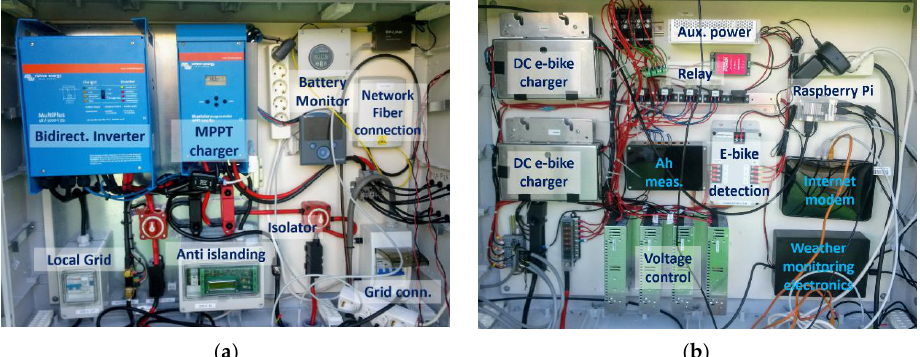
Figure 13. ( a ) Grid Inverter, PV MPPT charger, protection, and monitoring circuit. ( b ) DC-DC converter, control, and protection for DC charging of e-bike. control, and protection for DC charging of e-bike.